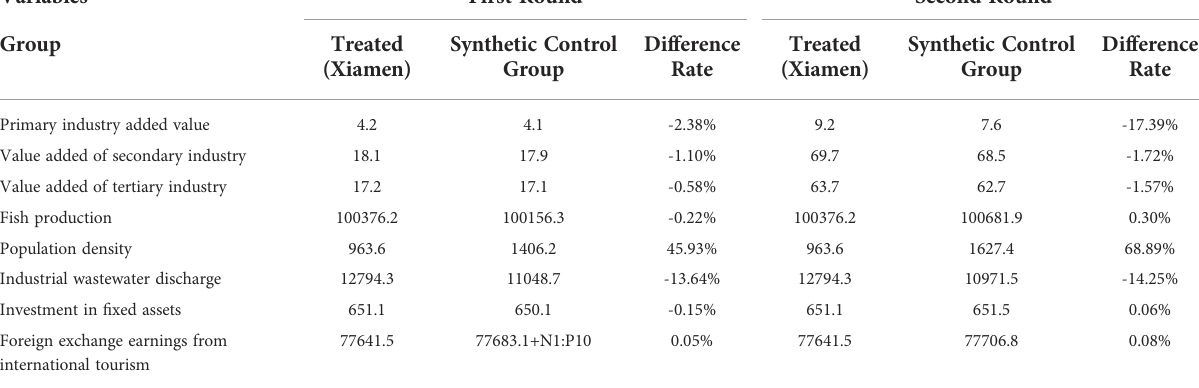
TABLE 5 The fi tting of control